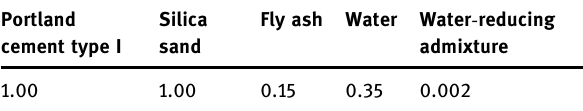
Table 2: Composition of mortar matrix by weight ratio